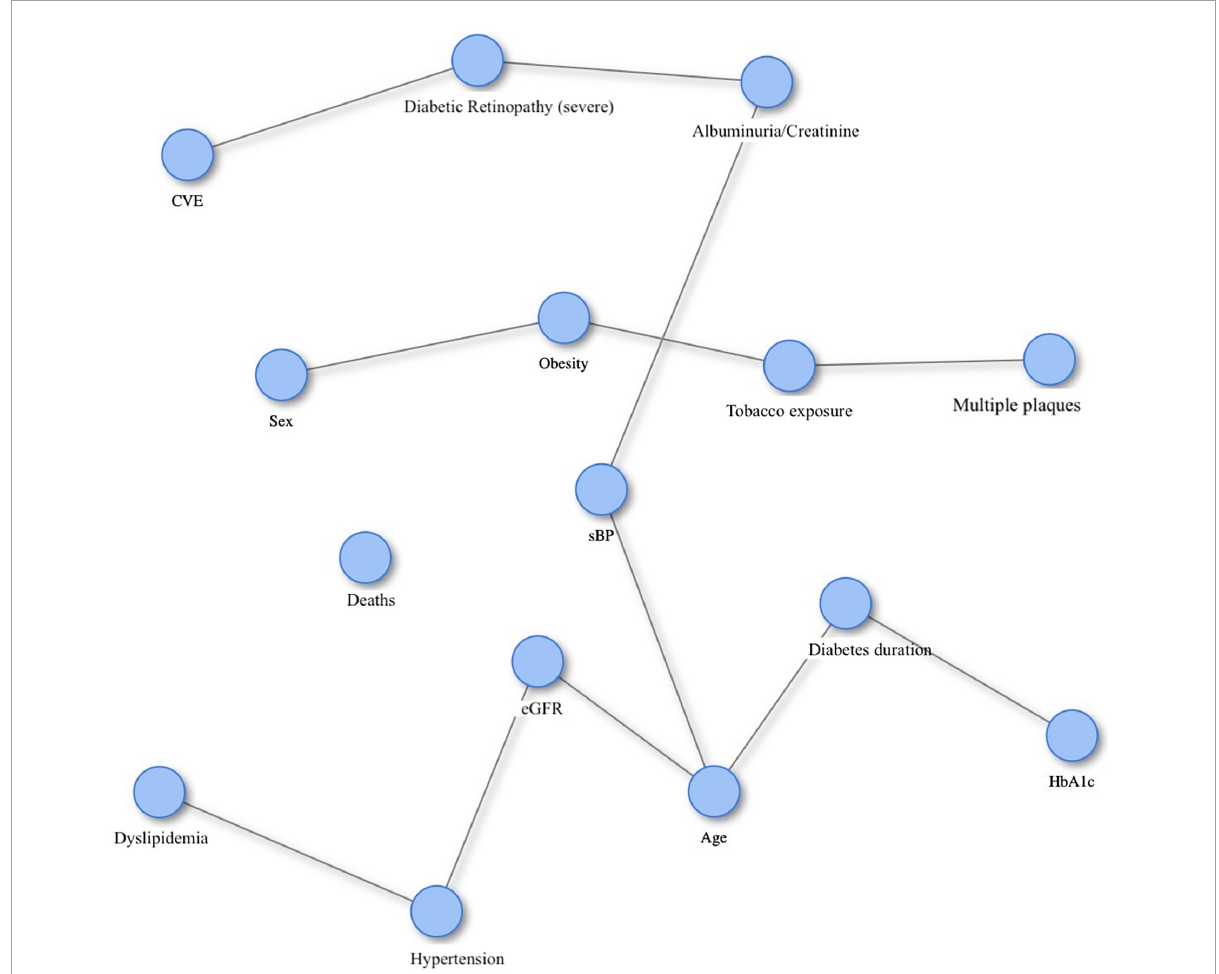
FIGURE3 The prediction causation algorithm for the causal relationship between diabetic retinopathy, subclinical atherosclerosis and cardiovascular events in subjects with type 2 diabetes. CVE, cardiovascular events; Multiple plaques, multiple carotid plaques (two or more); sBP, systolic blood pressure; eGFR, estimated glomerular filtration rate; DM_duration, diabetes mellitus duration; HbA1c, glycated